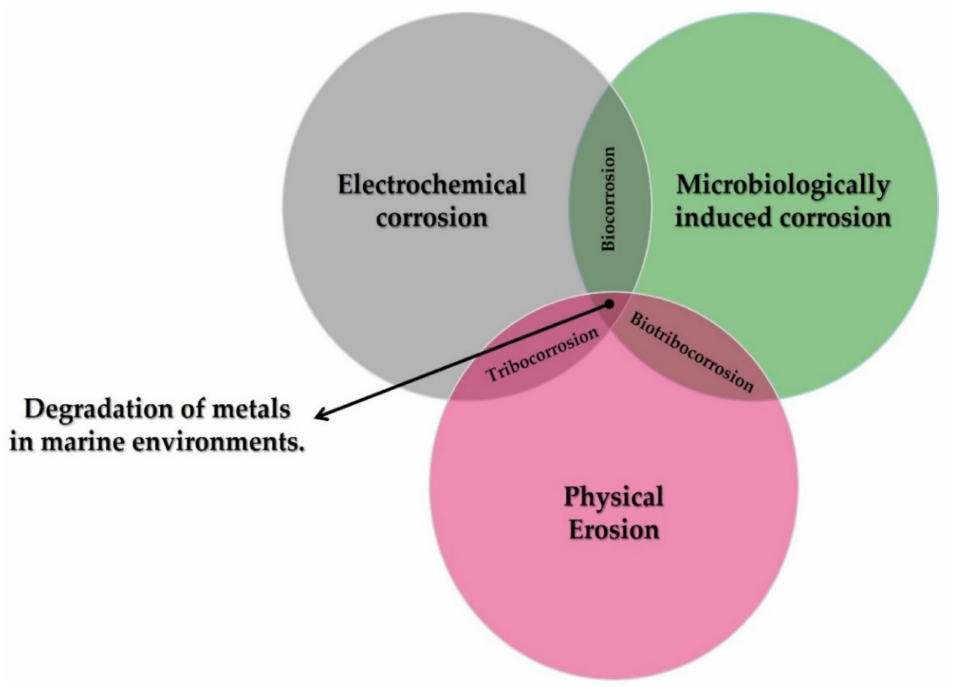
Figure 2. Different forms of metal degradation in marine